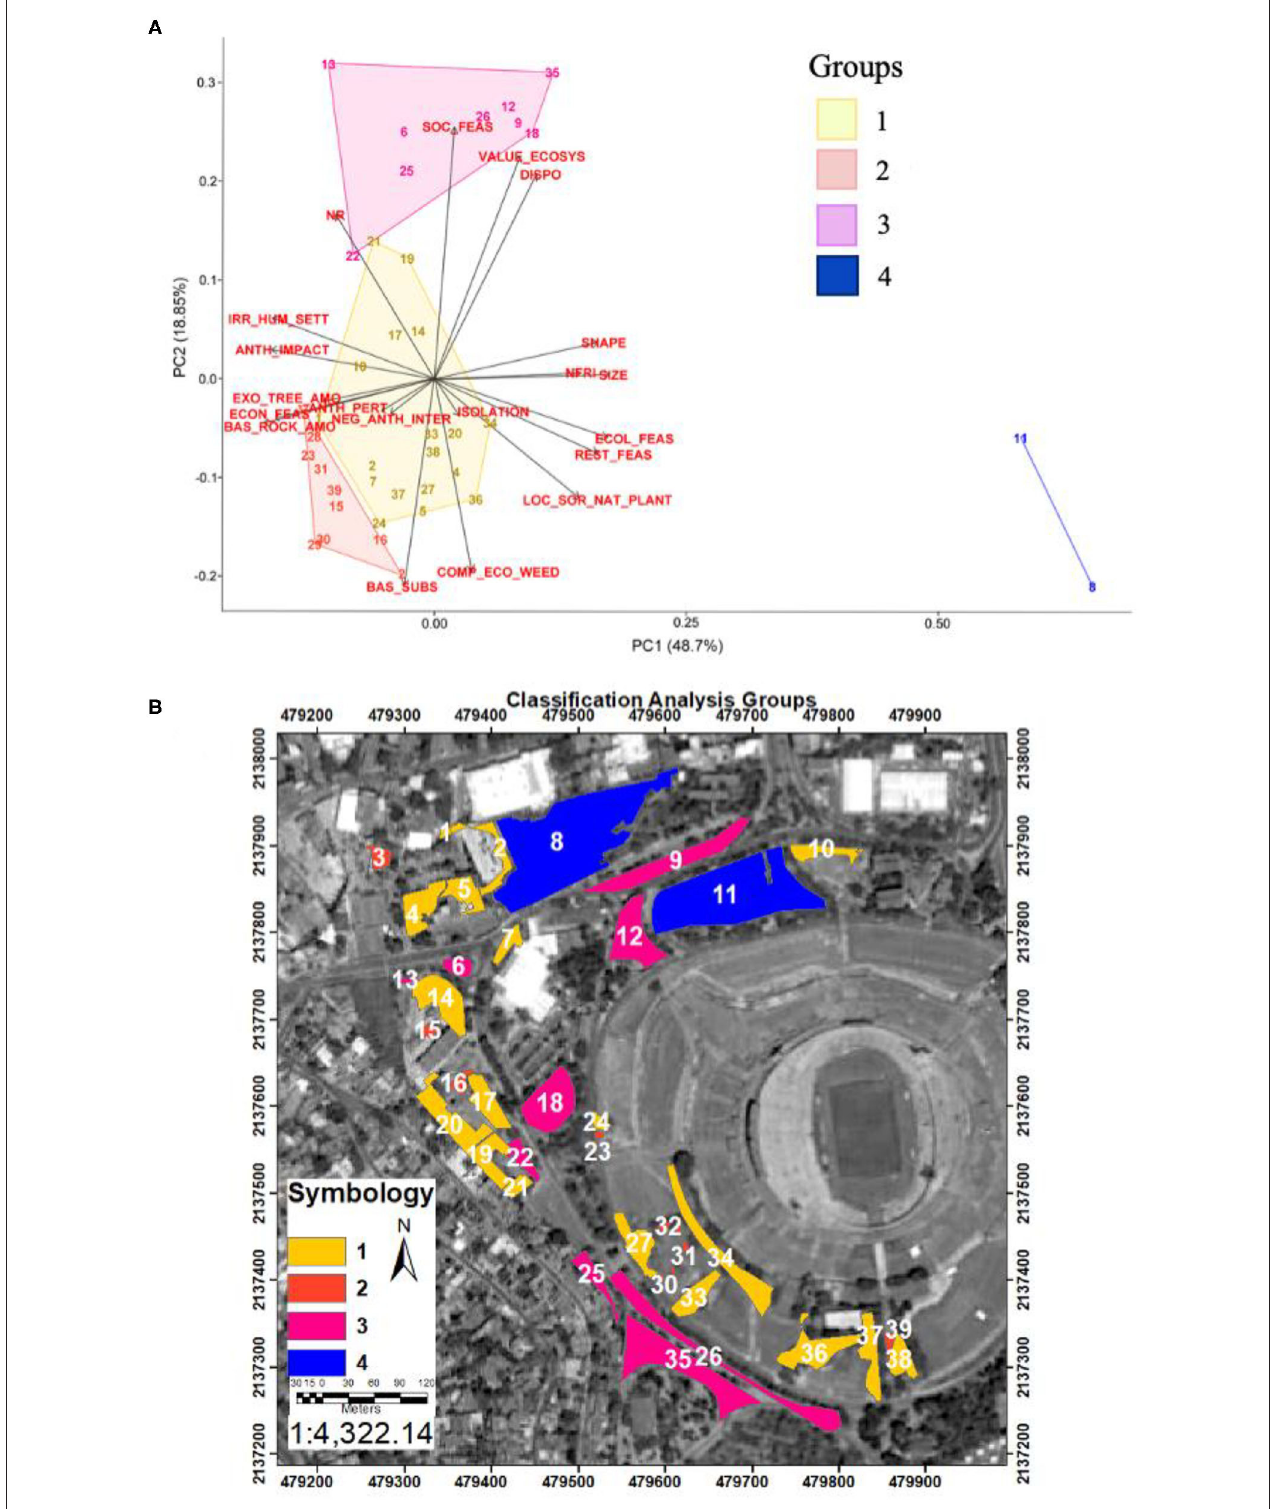
FIGURE 4 | Classification and principal components analysis results. (A) biplot of the principal component analysis where the different colors of the study site numbers represent the four groups obtained in the classification analysis. NR, need of restoration; LOC_SOR_NAT_PLANT, local source of native plant